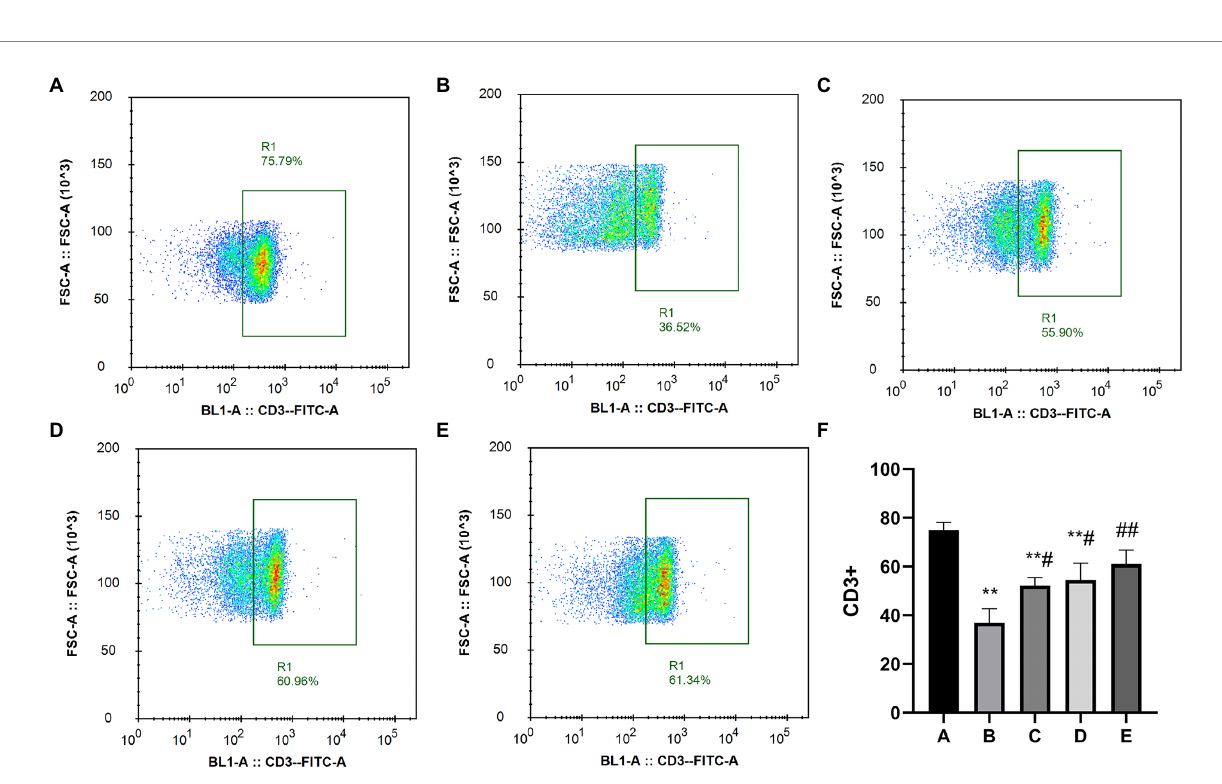
FIGURE 4 Effects of CSPCM on the percentage of CD3 + cells in Mesenteric lymph nodes. (A) The percentage of CD3+ cells in group A. (B) The percentage of CD 3+ cells in group B. (C) The percentage of CD3+ cells in group C. (D) The percentage of CD3+ cells in group D. (E) The percentage of CD3+ cells in group E. (F) Effect of CSPCM on percentage of CD 3+ cells in each